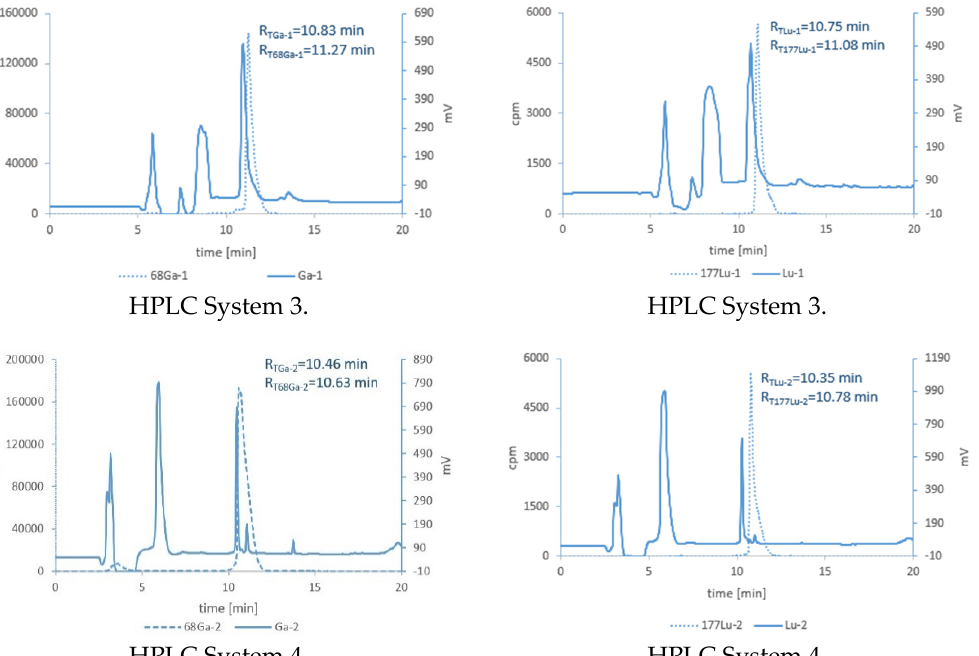
Figure 3. RP-HPLC chromatograms of the reaction mixtures of the cold reference compounds Ga- 1 , Lu-1 , Ga-2 , and Lu-2 —solid lines—and their corresponding radioconjugates 68 Ga-1 , 177 Lu-1 , 68 Ga- 2 , and 177 Lu-2 —dotted